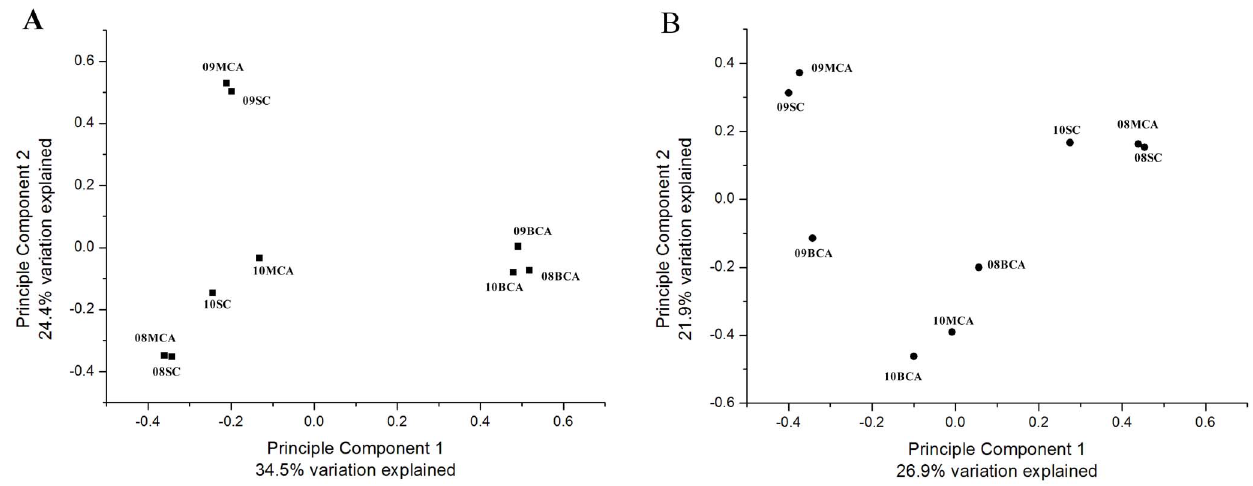
Figure 3. Principle component analysis of the phycosphere samples including cyanobacterial reads (A) and excluding cyanobacterial reads (B). The Yue and Clayton measure of dissimilarity between the structures of the communities was estimated and visualized using the dist.shared and pcoa commands of Mother.